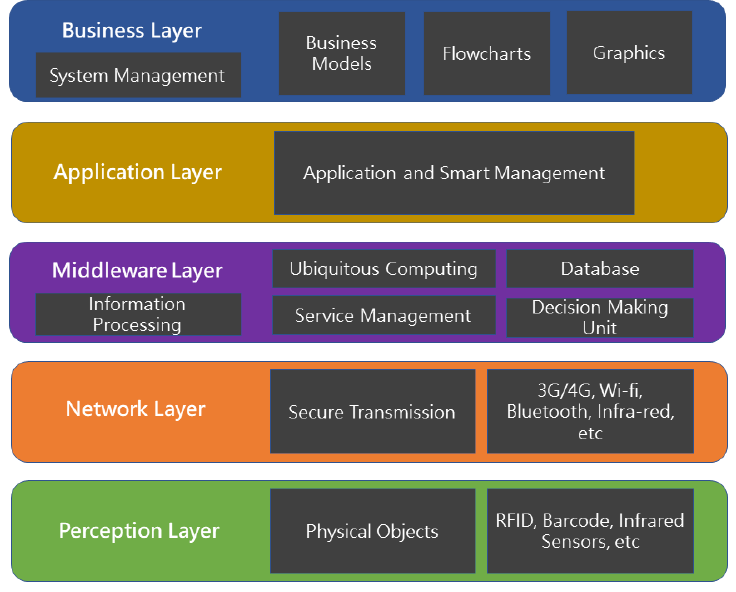
Figure 1. Layered architecture of IoT [14],